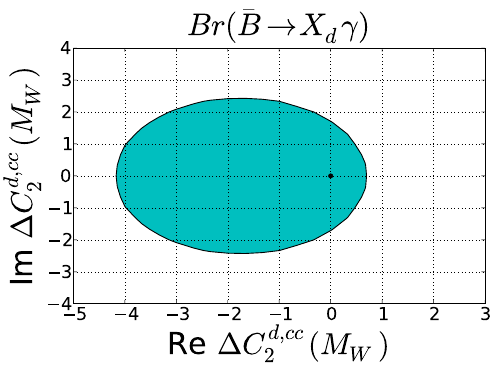
Figure 15 . Potential regions for the NP contributions in (cid:1) C d;cc B r ( (cid:22) B ! X d (cid:13) ) at 90% C.L. . The black point corresponds to the SM value.